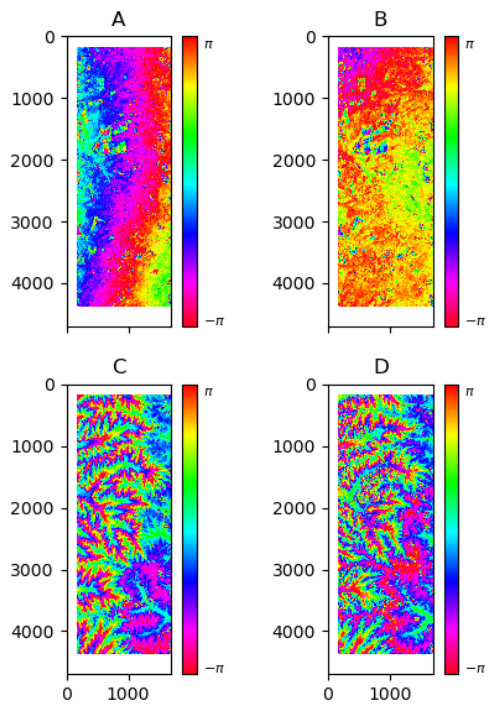
Figure 6. Results of the orbital correction for Pair 1 - HH Po- larization. A-B are the differential interferograms before and after correction, and C-D are the topographic interferograms be- fore and after correction, respectively (Note: These products are mapped in slant-range coordinates).